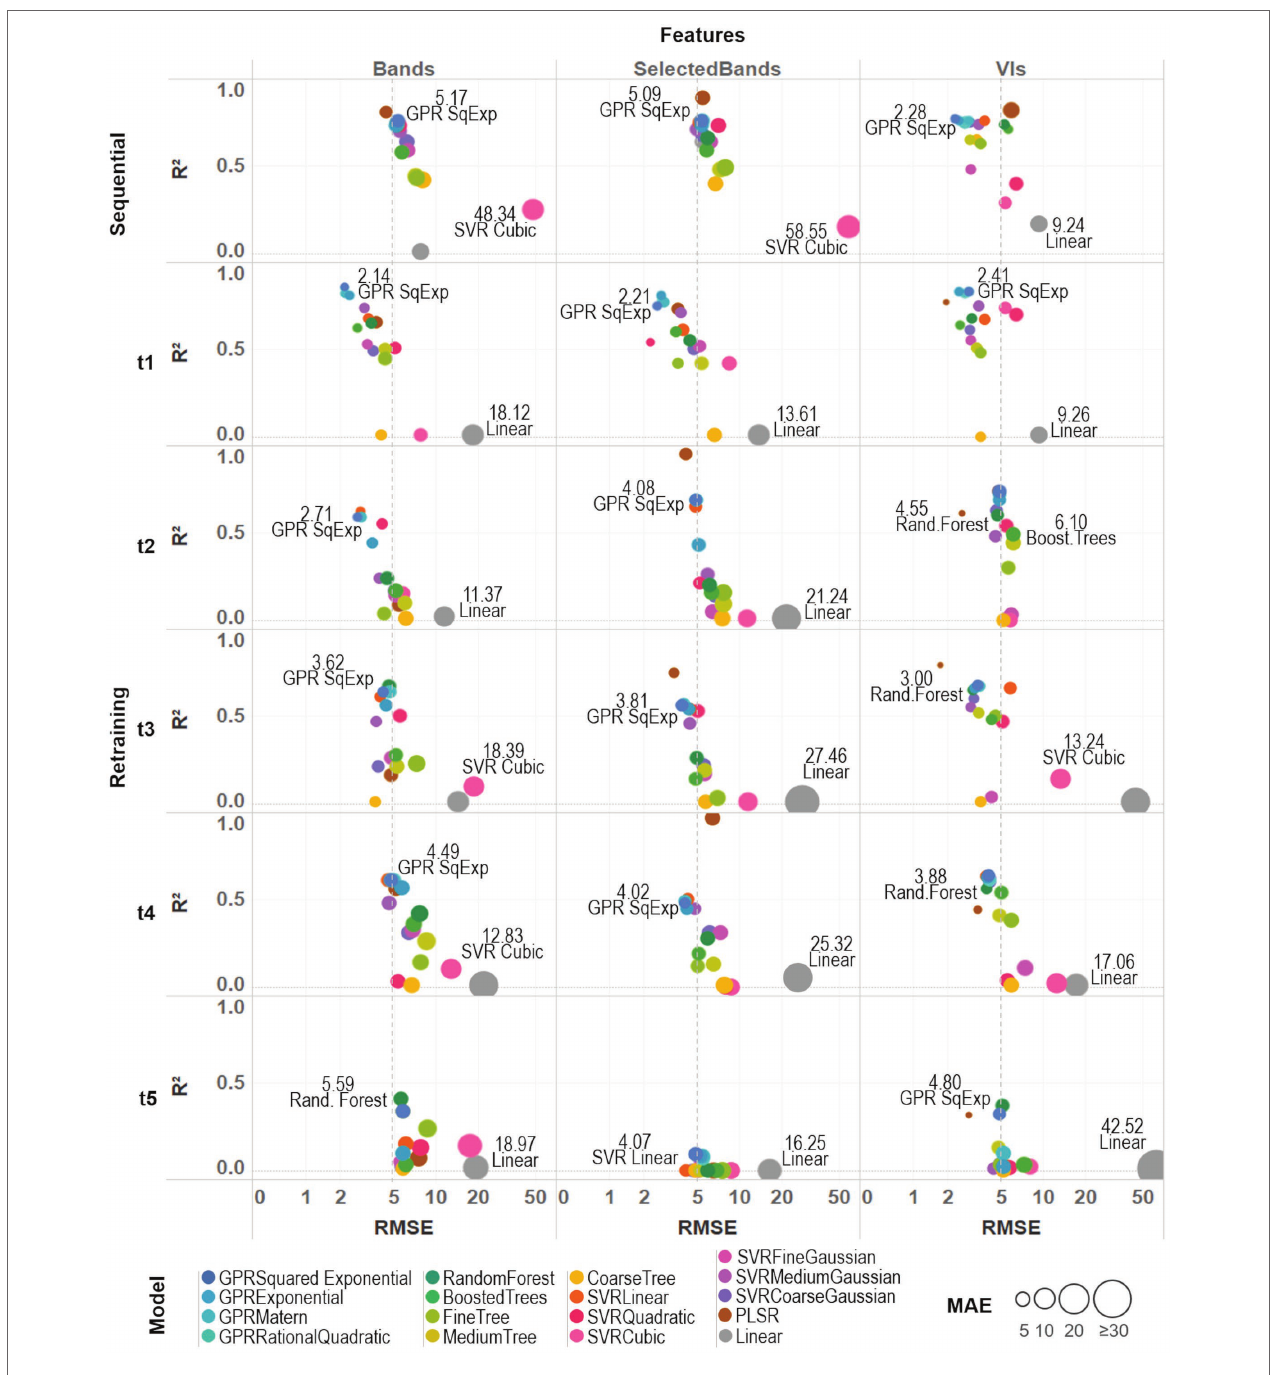
FIGURE 6 | A comparative assessment was performed between the 17 trained models by comparing three different metrics: R 2 , RMSE, and MAE. Model-fit and accuracy were evaluated under both training strategies (sequential and retraining) and considering different sets of prediction features (all spectral bands, selected bands from VIs, and VIs). An average prediction error threshold of 5 SPAD units was established to evaluate individual model accuracy (dashed line). Base-10 log scale is used for the x -axis